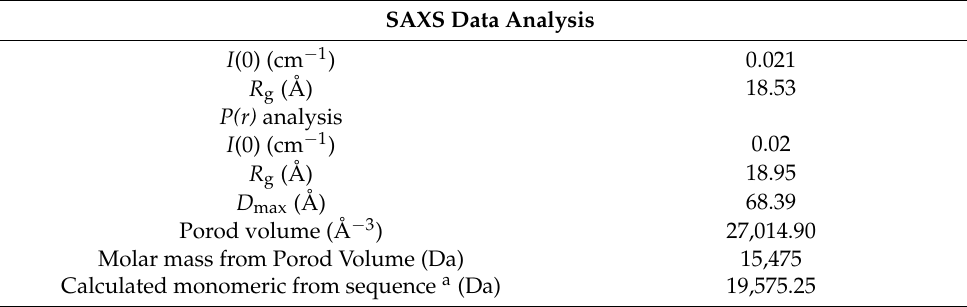
Table 2. Data analysis from the LysF1 SAXS